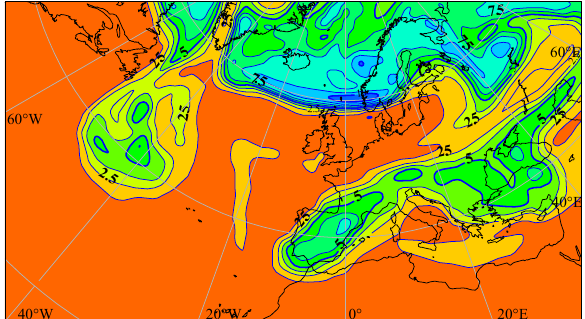
Fig. 9. Contour map of Potential vorticity (at 330K) obtained from ECMWF analysis for: (1) the 8 July 2008 at 12:00UTC (upper panel); (2) the 9 July 2008 at 12:00UTC (middle panel); (3) the 10 July 2008 at 12:00UTC (lower